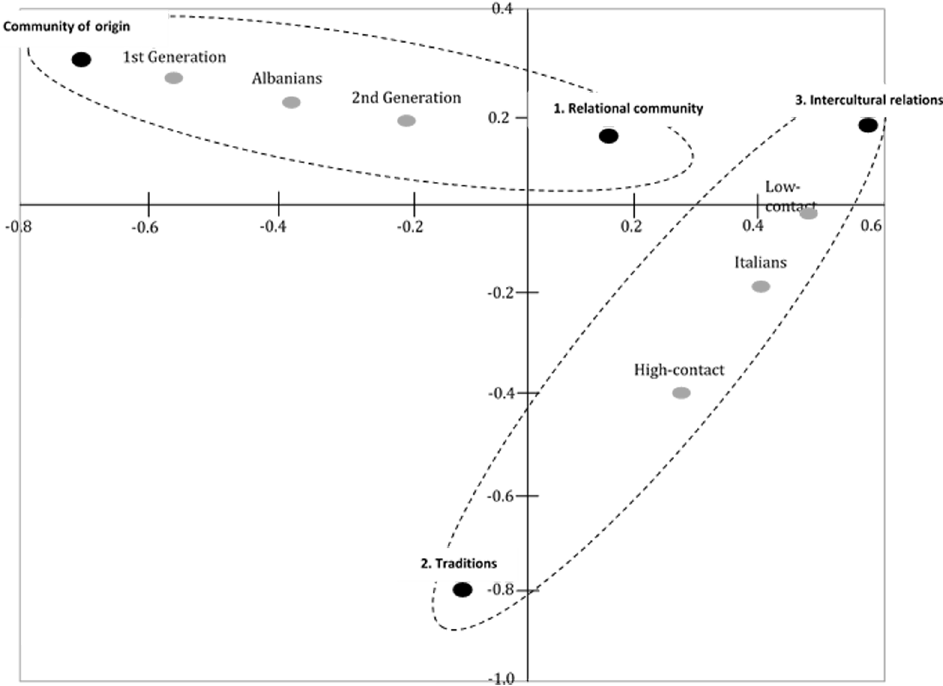
People of Albanian descentNative-born Italians